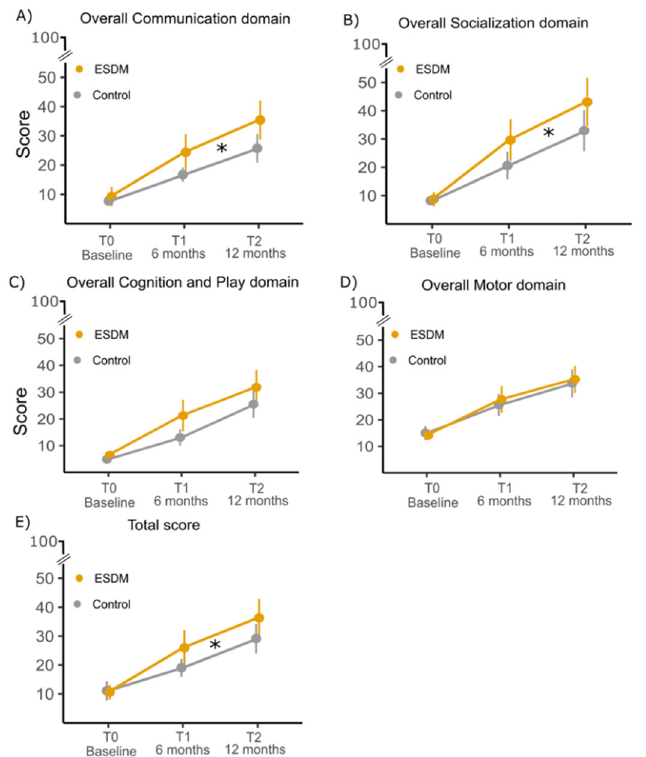
Figure 1. Group means and 95% confidence intervals expressed as percentage relative to ESDM checklist domain scores of the ESDM group ( n = 19) and TAU group ( n = 19). Scores in the communication ( A ); socialization ( B ); cognition and play ( C ); motor domain ( D ) and the combination of the communication, socialization, cognitive–play, and motor ( E ) areas of the ESDM group increased after treatment in comparison to the TAU group. Asterisks indicate significant differences between